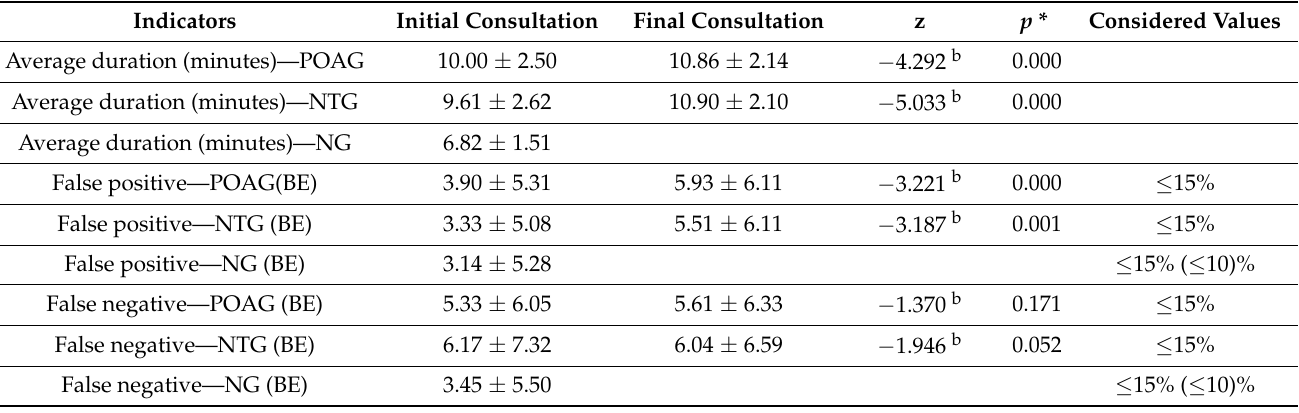
Table 4. Distribution of credibility indices in the interpretation of the visual field result between the first and last consultation in POAG, NTG, and NG patients.